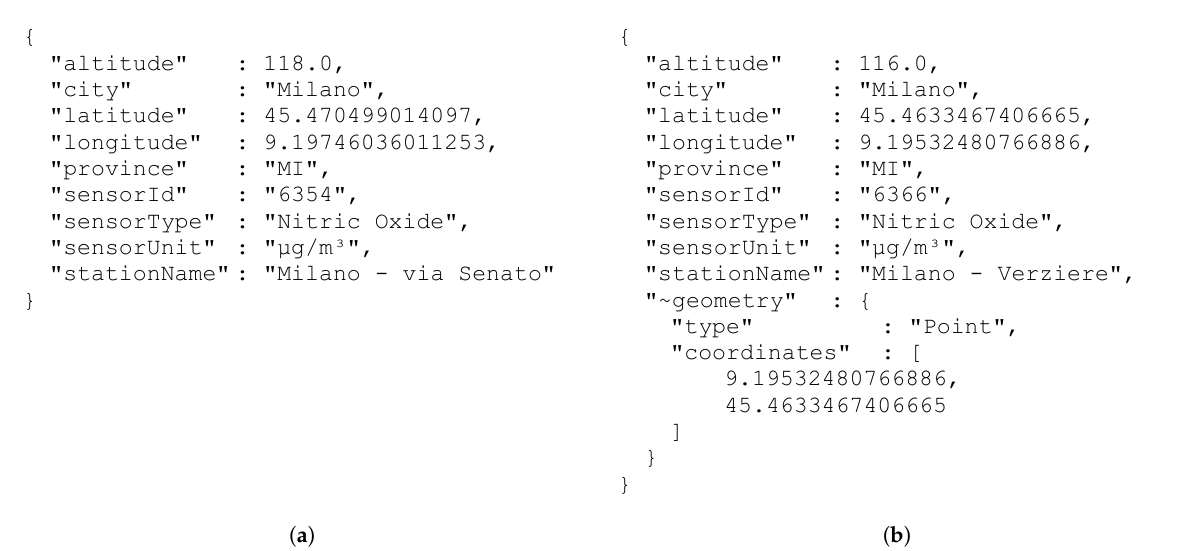
Figure 7. Example of a document in the temporary collection generated by line 9 ( a ) and by line 10 ( b ). ( a ) Example of an air-quality sensor document without geo-reference. ( b ) Example of an air-quality sensor document with